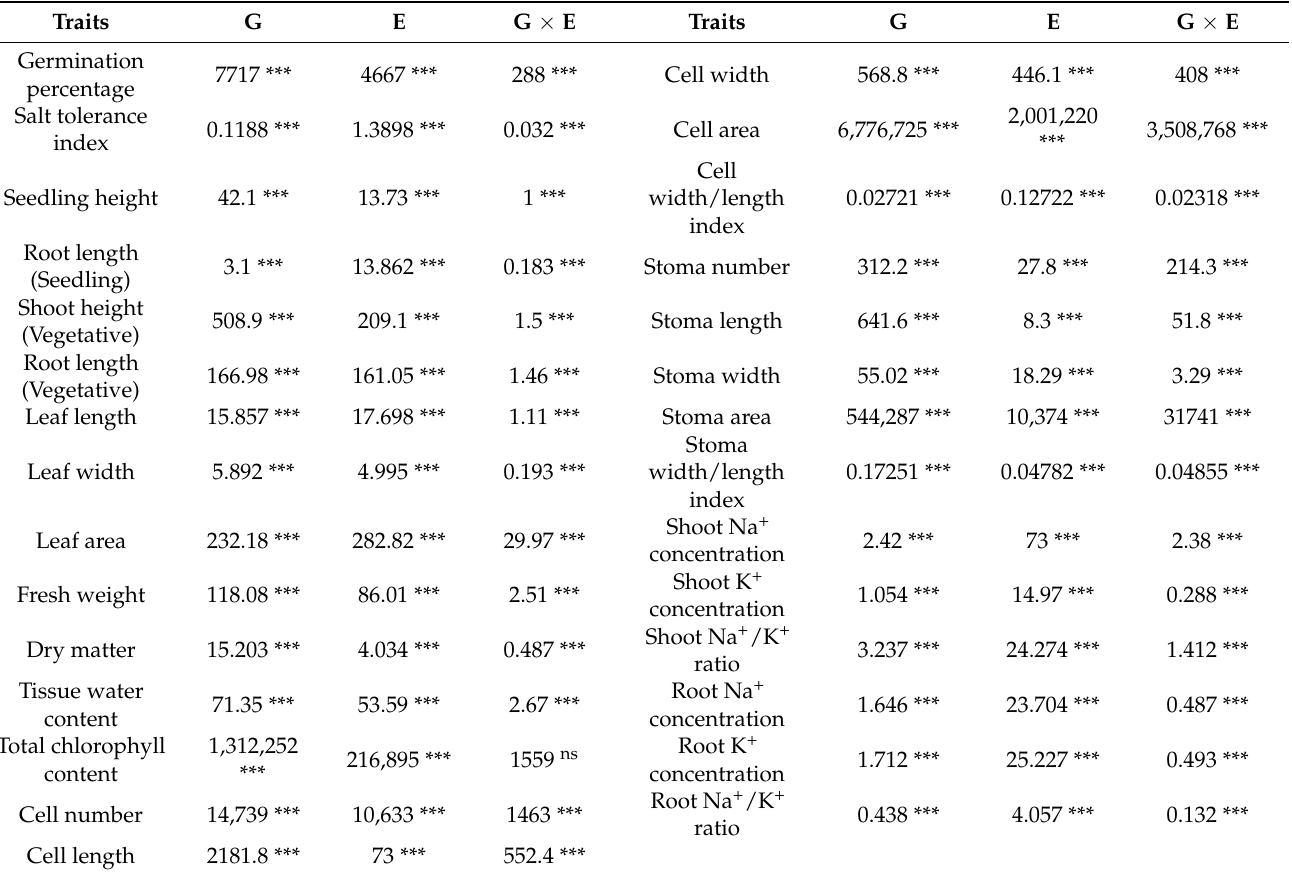
Table 1. ANOVA analysis of genotype and environment on traits. Numbers represent mean